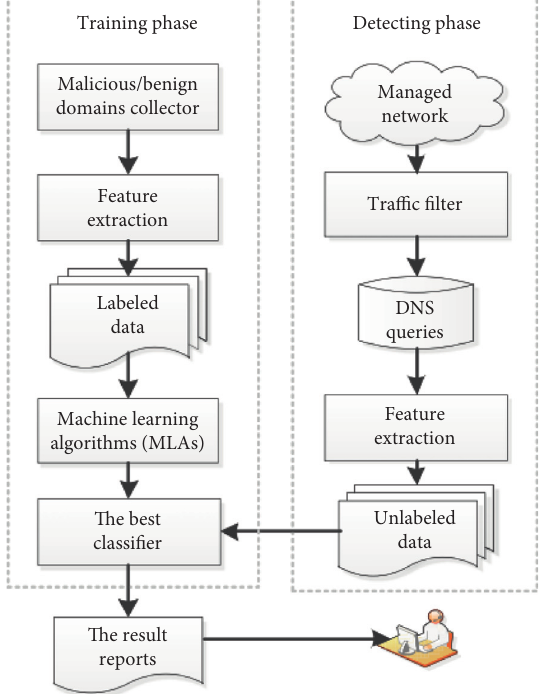
Figure 3: Framework of the detection system. MLA: machine learning algorithm; DNS: domain name